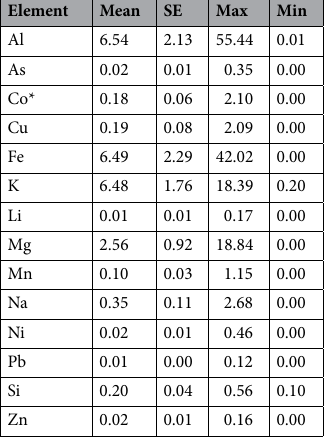
Table 2. Descriptive statistics for the concentration (µg g −1 ) of chemical elements found in the snow samples (n = 39) collected at the Andes. The mean, standard error (SE) and range (Min–Max) of the concentration of each element is shown. Minimum concentrations with zero value indicate element was not detected in some points. *Value × 100.